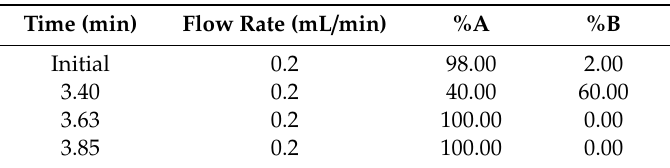
Table 1. Solvent gradient system for UPLC-based peptide mapping of tryptic digests of wild-type (Wt) and mutant (Mut2)